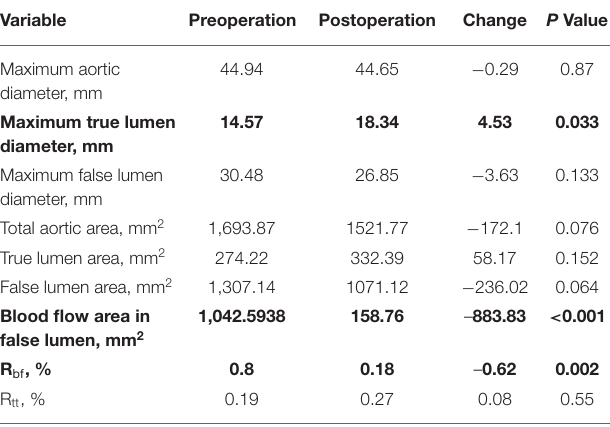
TABLE 3 | Impact of RBS on aortic